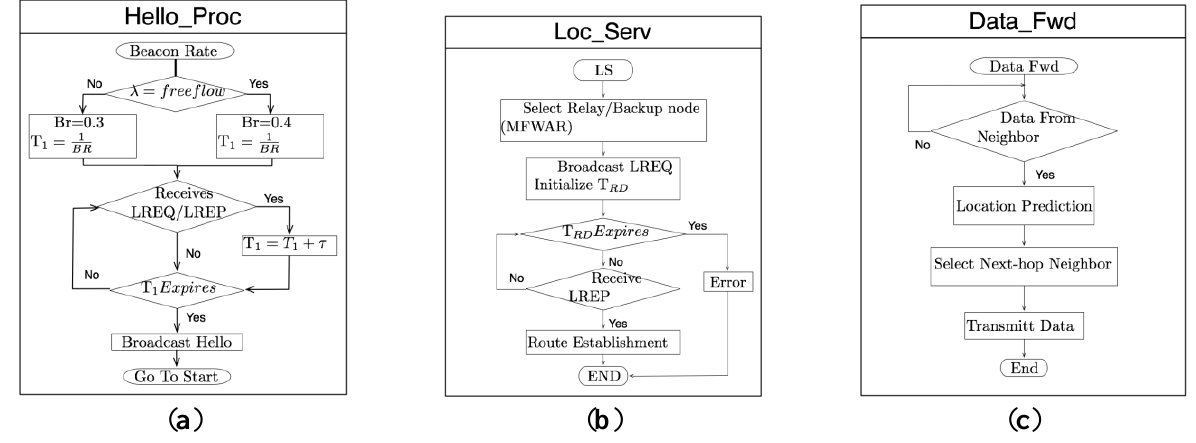
Figure 5. Flow charts for the main processes of the FPBR protocol: ( a ) The Hello mechanism; ( b ) the location service and ( c ) the data dissemination service.